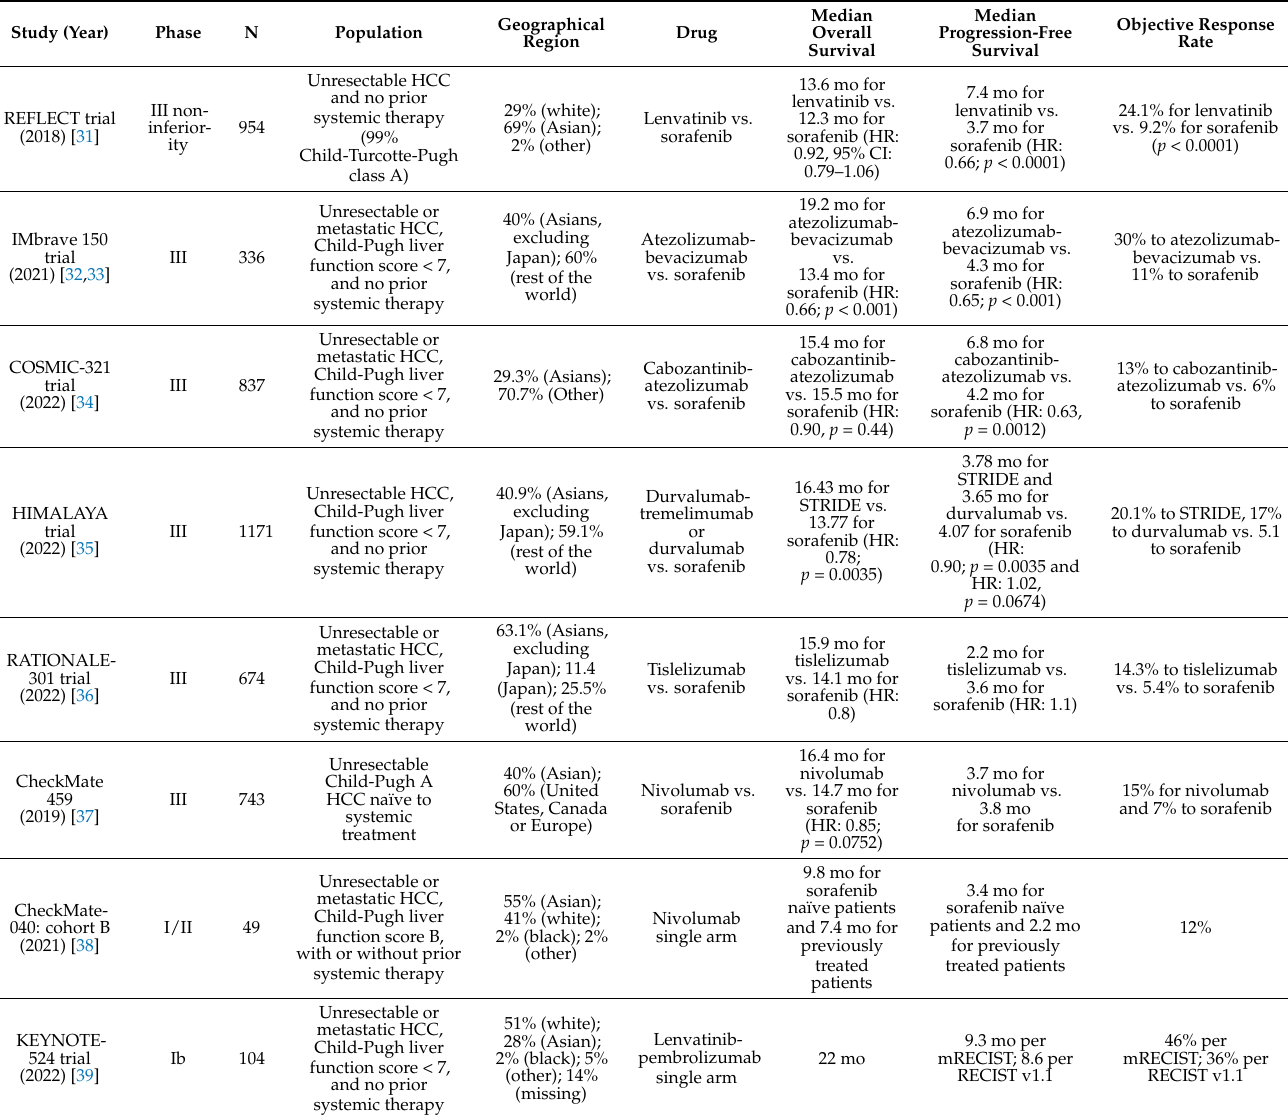
Table 1. Results of selected trials for first-line therapy in patients with advanced